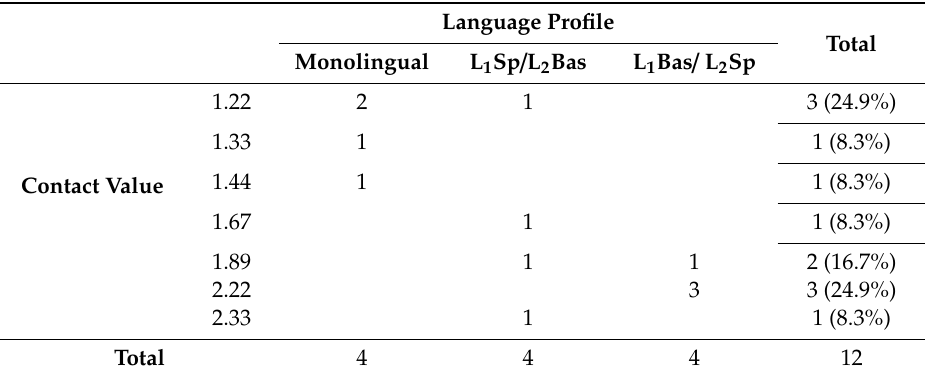
Table 7. Degree of contact according to the speakers’ language profile and